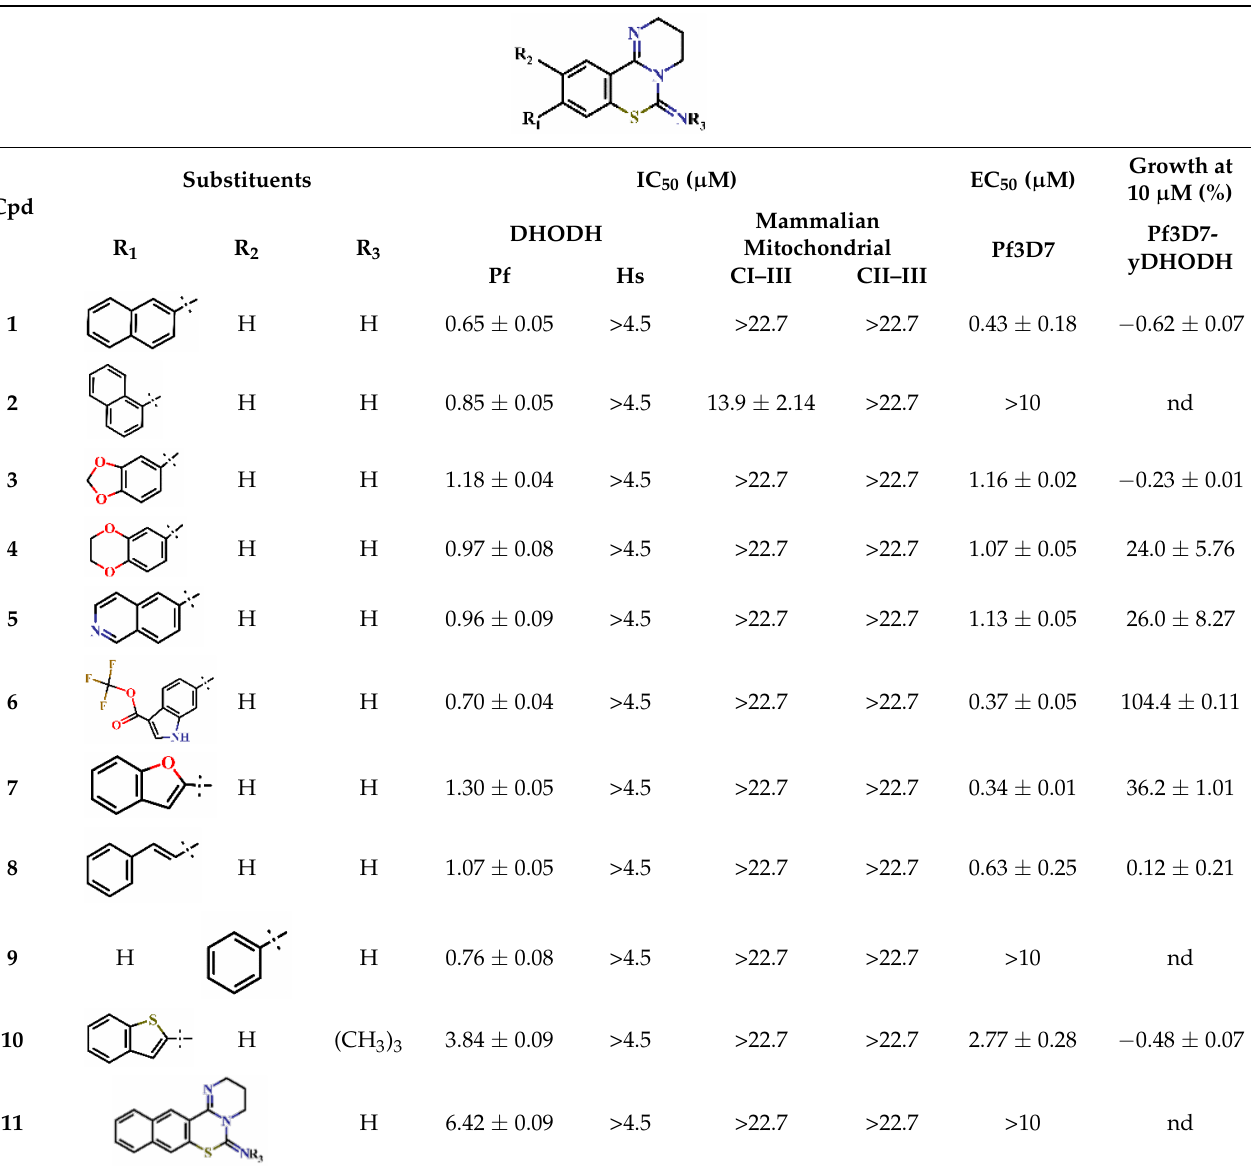
Table 1. Antimalarial activities of DPBI